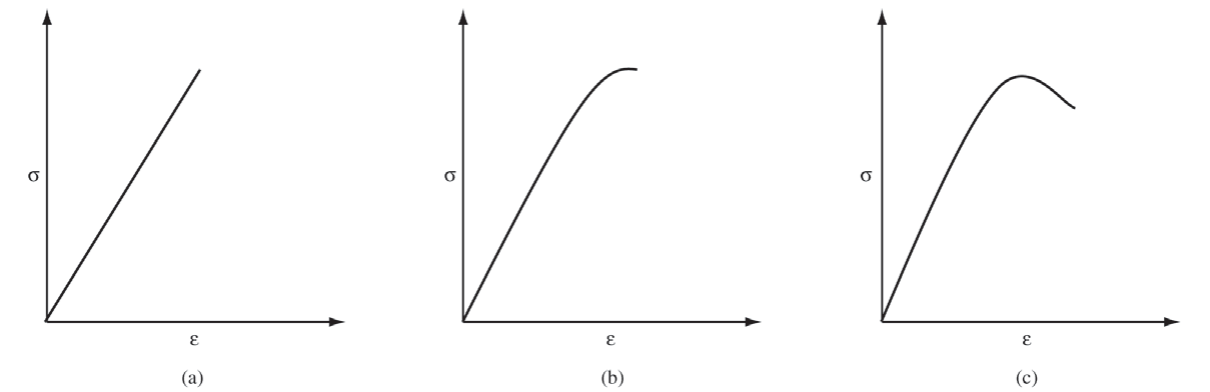
Figure 3. Schematic of the engineering stress-strain curves for the different epoxy formulations analysed. a) Brittle behaviour common to epoxy rich formulations; b) Quasi- brittle behaviour shown by the amine rich and the aged stoichiometric formulations; c) Ductile behav- iour shown by the as fabricated and aged amine rich